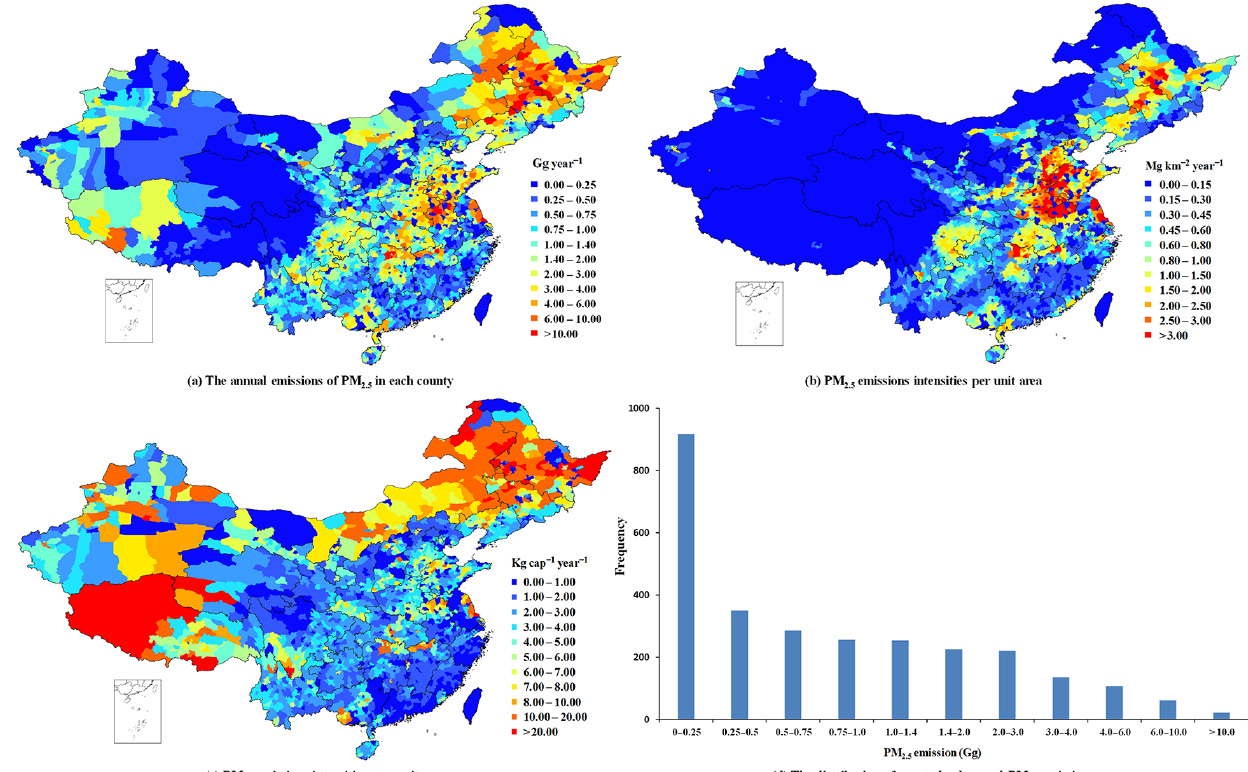
Figure 6. Biomass emission inventory at county resolution and intensity (PM 2 . 5 ).